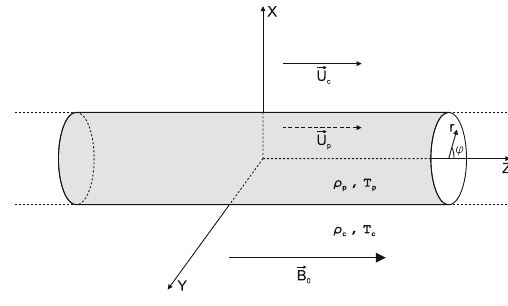
Fig. 44 Sketch of an infinitely long thread immersed in the solar corona. The respective flow speeds in the thread and the corona are denoted by U p and U c . Image reproduced with permission from Soler et al. (2008), copyright by